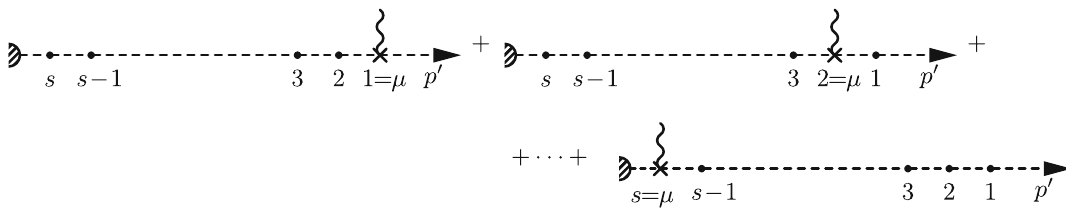
Fig. 2 Set of ( s + 1 ) diagrams showing all possible trilinear insertions of a virtual photon at vertex μ on the p (cid:8) leg of a scalar/fermion